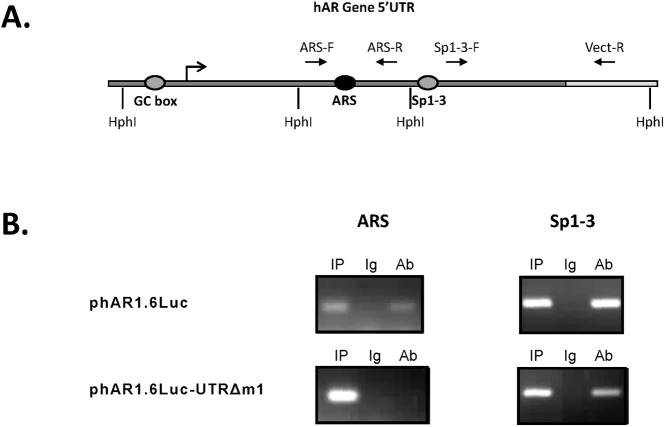
ChIP analysis confirms binding of Sp1 to 5’UTR ARS.(A) Line diagram (not to scale) of the hAR 5’UTR showing the recognition sites of the restriction endonuclease HphI used to digest plasmid, plus the forward (F) and reverse (R) primers (solid arrows) used for ChIP semi-quantitative PCR. Oligonucleotide Vect-R was specific for the plasmid vector sequences, and the bent arrow indicates the transcriptional start site. (B). Representative agarose gels of PCR amplified DNA immunoprecipitated with anti-Sp1 antibody in which the order of some lanes have been altered to aid clarity and facilitate comparisons; IP, input sample; Ig, pre-immune rabbit IgG; Ab, anti-Sp1 antibody.